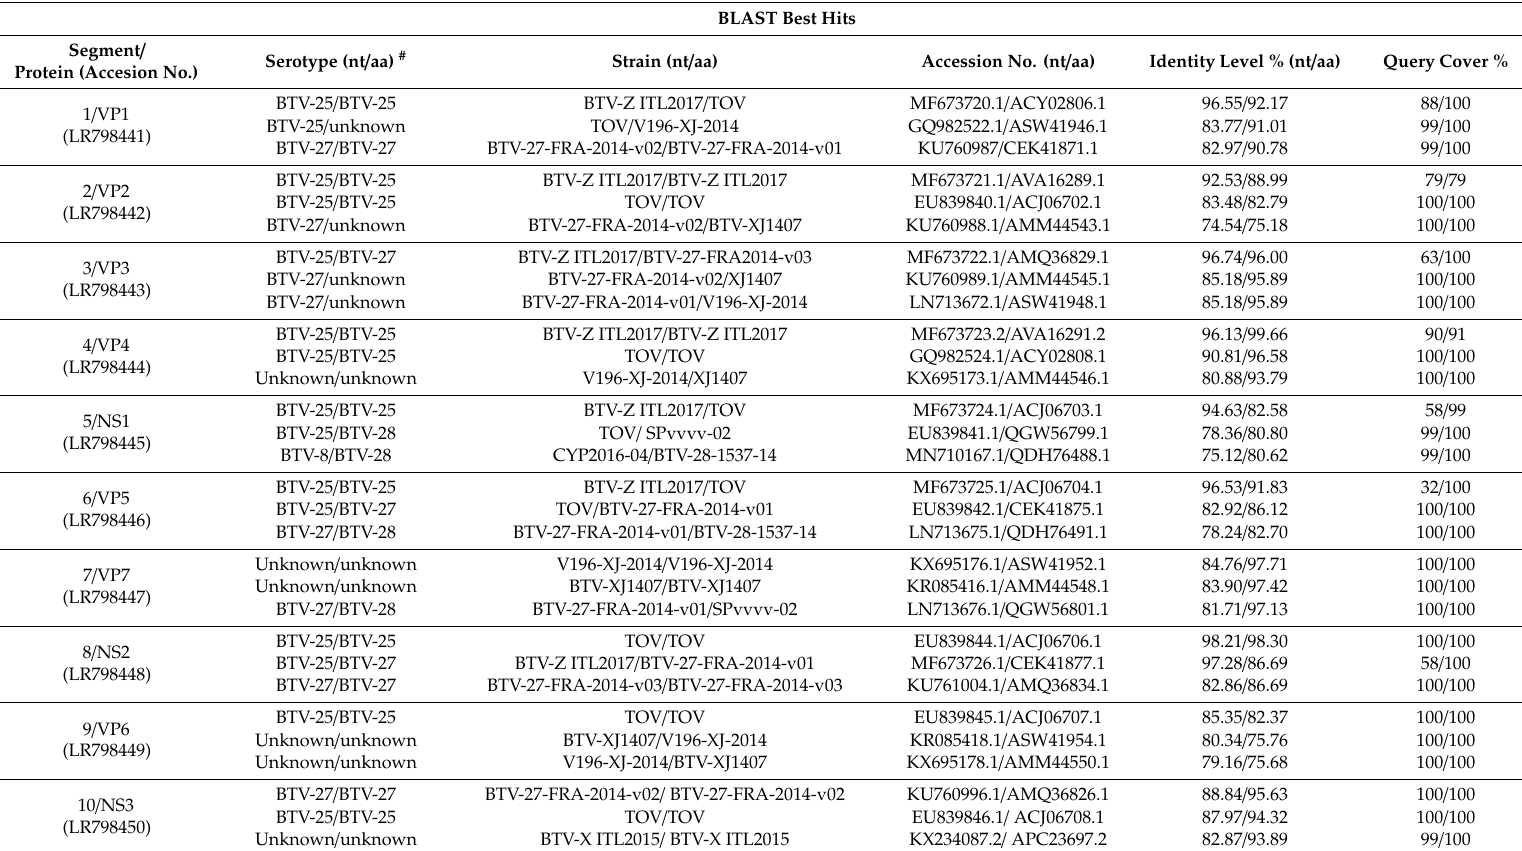
Table 1. Closest neighbors of Bluetongue virus (BTV)-25GER2018 (CDS) following BLAST analyses. The three highest identities / similarities are presented. BLAST Best